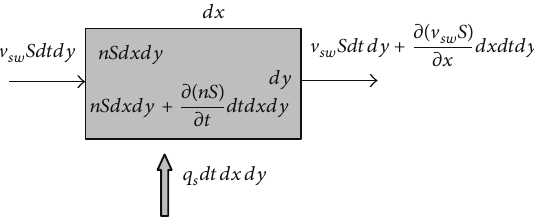
Figure 2: Unit body of underground sediment